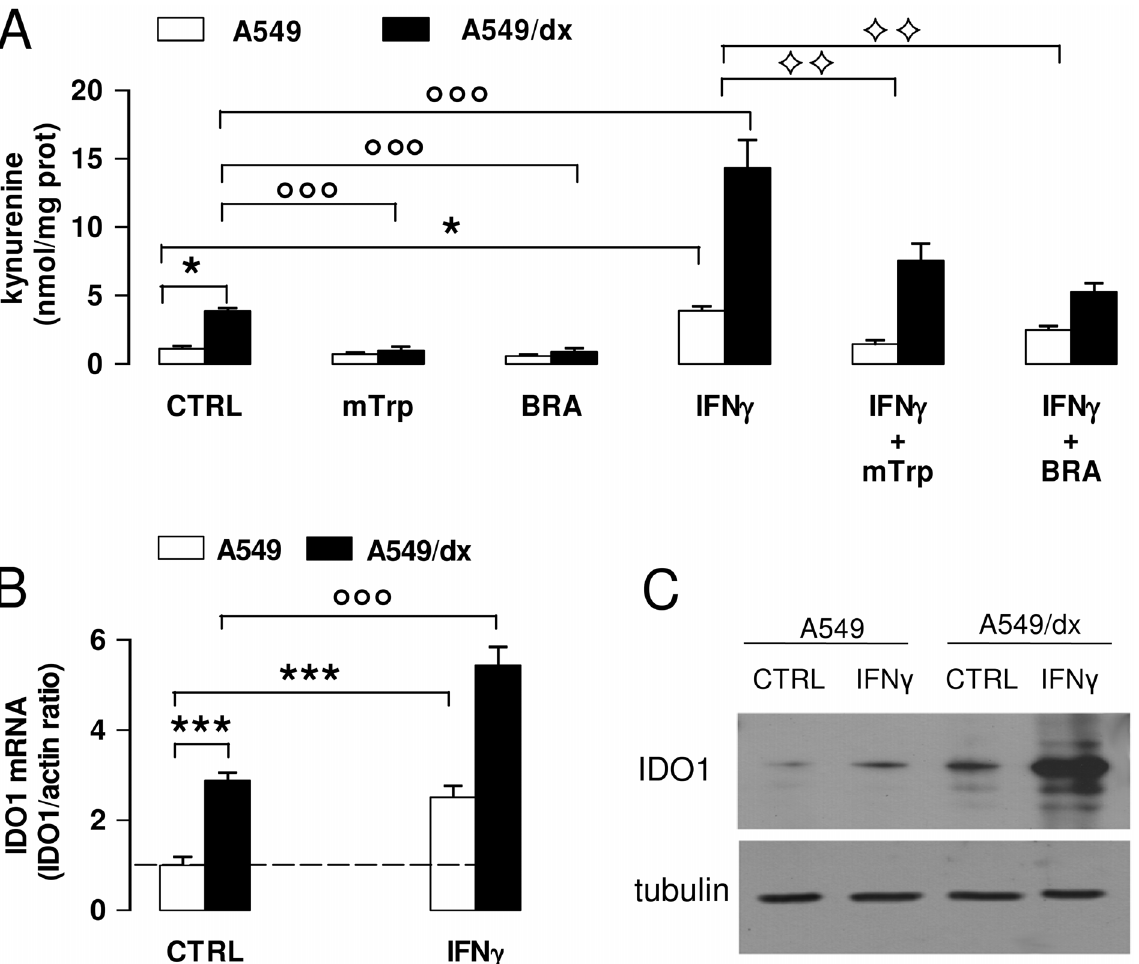
Fig 3. Effects of IFN- γ on kynurenine synthesis and IDO1 expression in chemosensitive and multidrug resistant cells. A549 and A549/dx cells were incubated for 48 h in fresh medium (CTRL) or in medium containing the IDO1 inhibitors methyl-DL-tryptophan (1 mmol/L, mTrp) or 5-Br-brassinin (100 μ mol/ L, BRA), and the IDO1 inducer IFN- γ (100 ng/mL, IFN γ ), alone or in combination. A . The kynurenine levels in the cell culture supernatants were measured spectrophotometrically. Data are presented as means ± SD (n = 4). * p < 0.01: versus A549 CTRL cells; °°° p < 0.001: versus A549/dx CTRL; ^^ p < 0.005: IFN- γ + mTrp-treated, IFN- γ + BRA-treated A549 and A549/dx cells versus the corresponding cells treated with IFN- γ alone. B . The expression level of IDO1 mRNA was measured by qRT-PCR. Data are presented as means ± SD (n = 4). *** p < 0.001: versus A549 CTRL cells; °°° p < 0.001: versus A549/dx